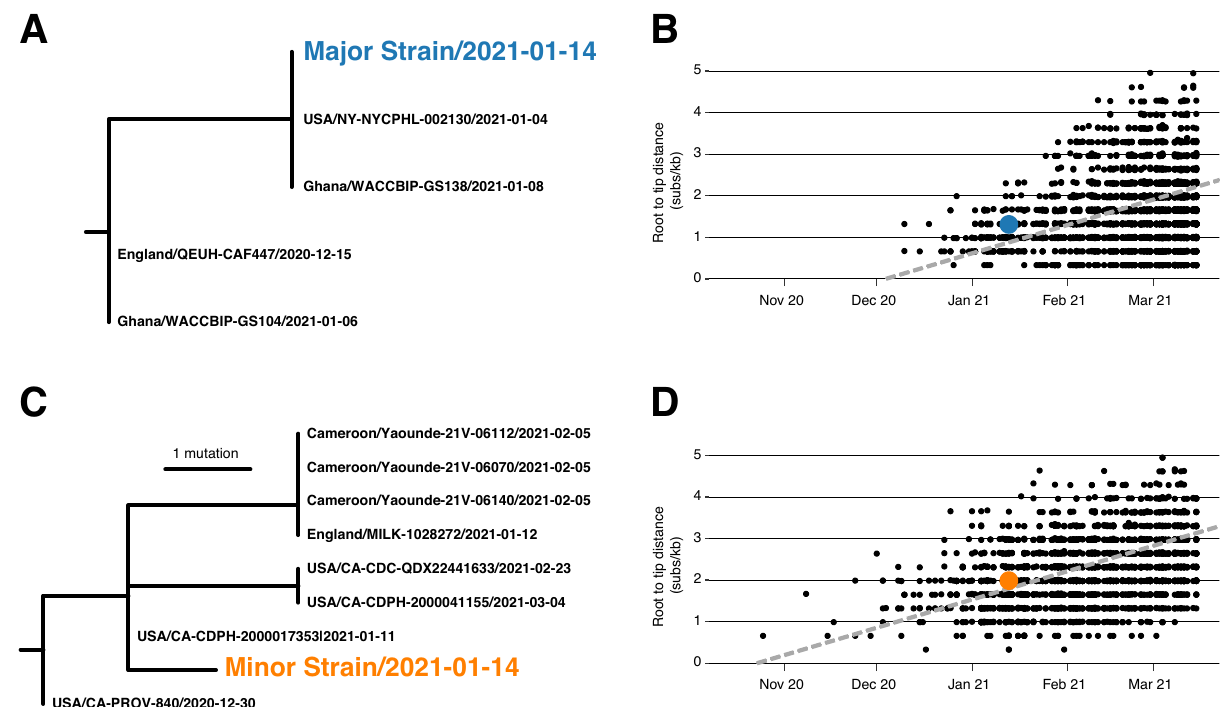
Fig. 2 Phylogenetic consistency of major and minor variants. A Phylogeny of Alpha variant immediate relatives. B Root-to-tip regression for Alpha variant. C Phylogeny of Epsilon variant immediate relatives. D Root-to-tip regression for Epsilon variant. NY-NYCPHL-002461 is the genome deposited in GISAID from the case of putative superinfection. NY-NYCPHL-002130 is the genome from the index case. Table 3 Four gamete recombination test results for 15 sets of aligned read fragments in the S (spike) and N (nucleoprotein)